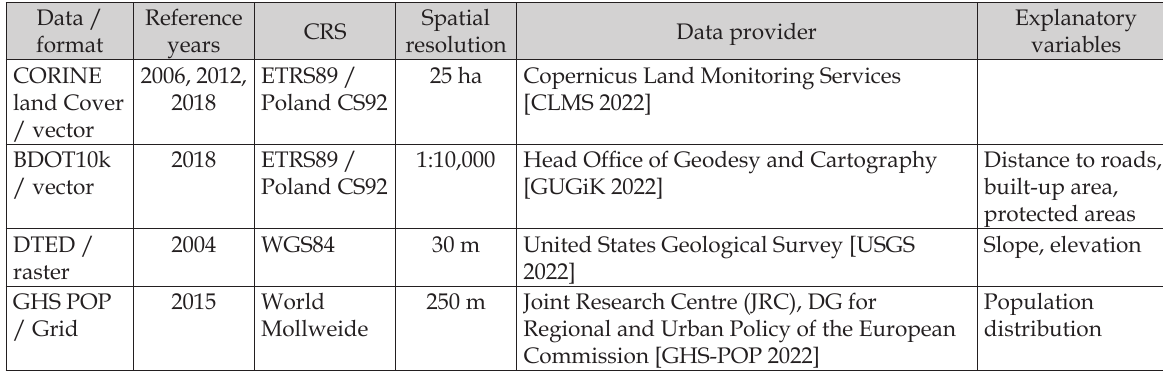
Table 1. Summary of data used.